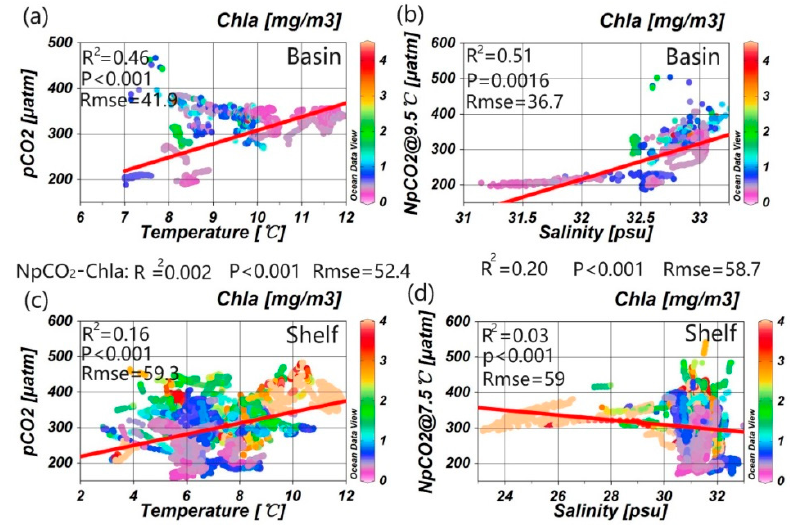
Figure 2. The relationship between p CO 2 , temperature, and salinity in the basin ( a , b ) and shelf ( c , d ) from July to September during 2000 to 2013. N p CO 2 denoted the in situ pCO 2 normalized to an average temperature of subset as 9.5 °C and 7.5 °C in basin ( b ) and shelf ( d ), respectively.